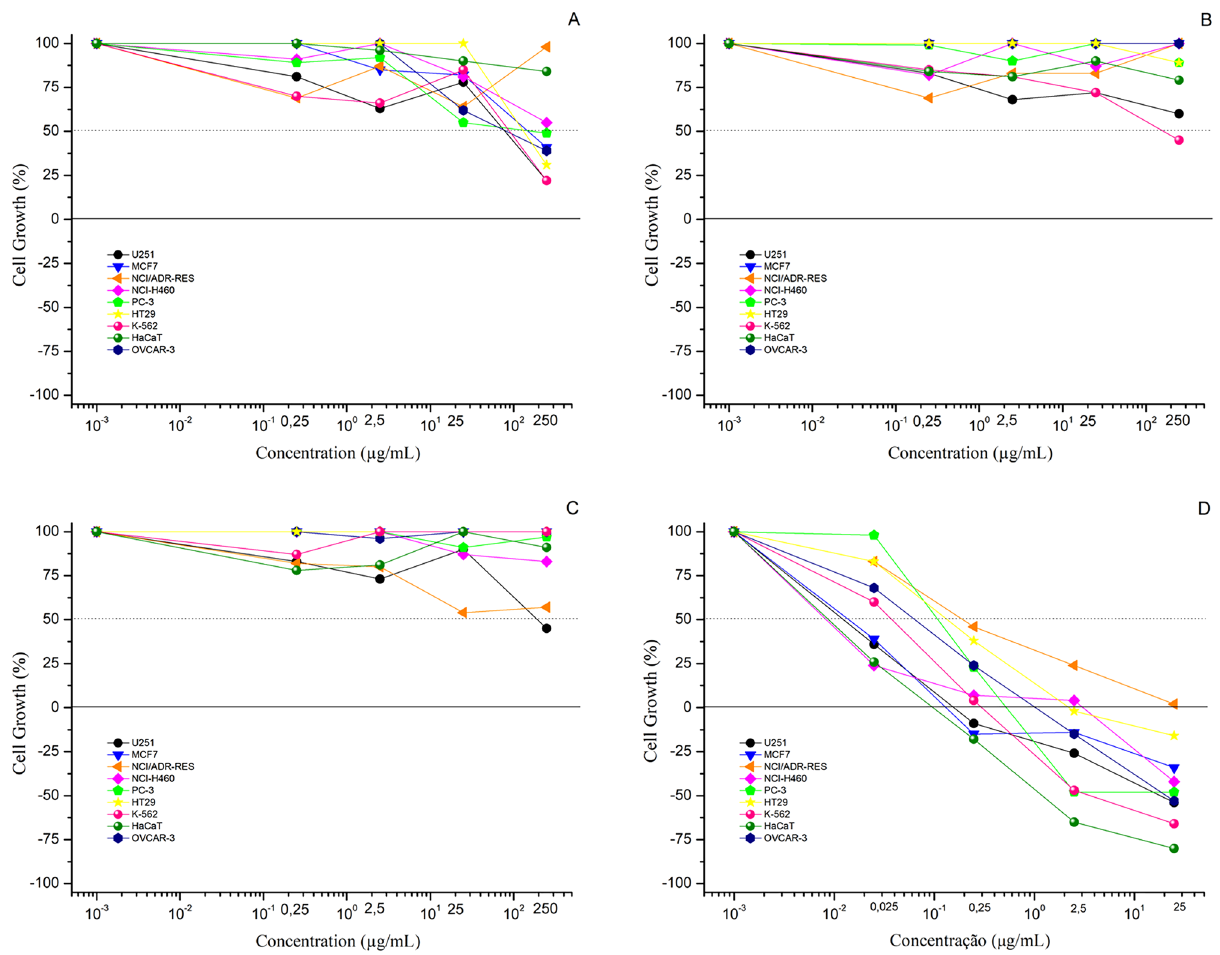
Figure 3. Antiproliferative activity of free bromelain solution ( A ), chitosan-bromelain nanoparticles ( B ), chitosan nanoparticles ( C ), and doxorubicin ( D ) after 48 h exposition. Graphs were created by authors using average data with standard deviation (n = 3) from antiproliferative assay, using Origin software (version 8.1.34.90, OriginLab Corporation).